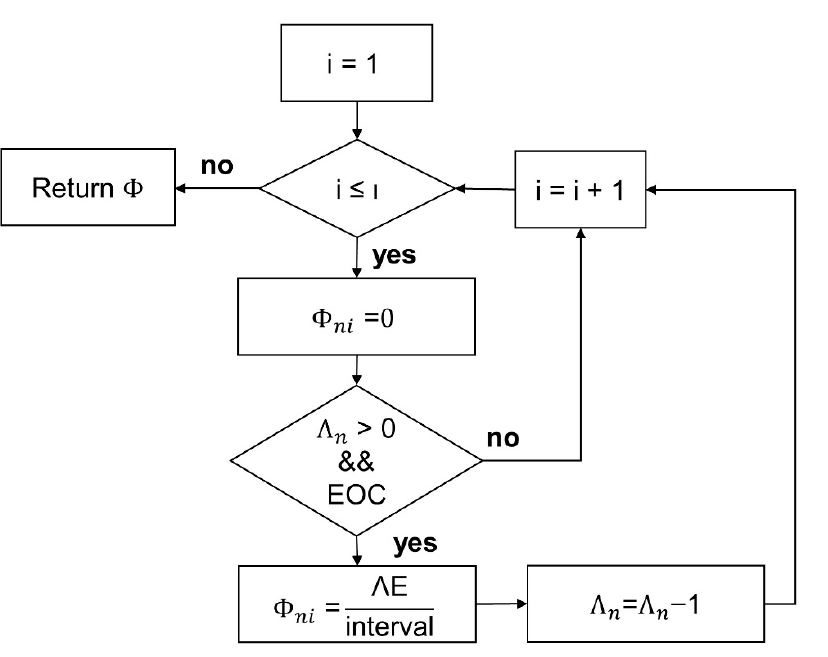
Figure 3. Formulation of the flexibility pattern Φ .